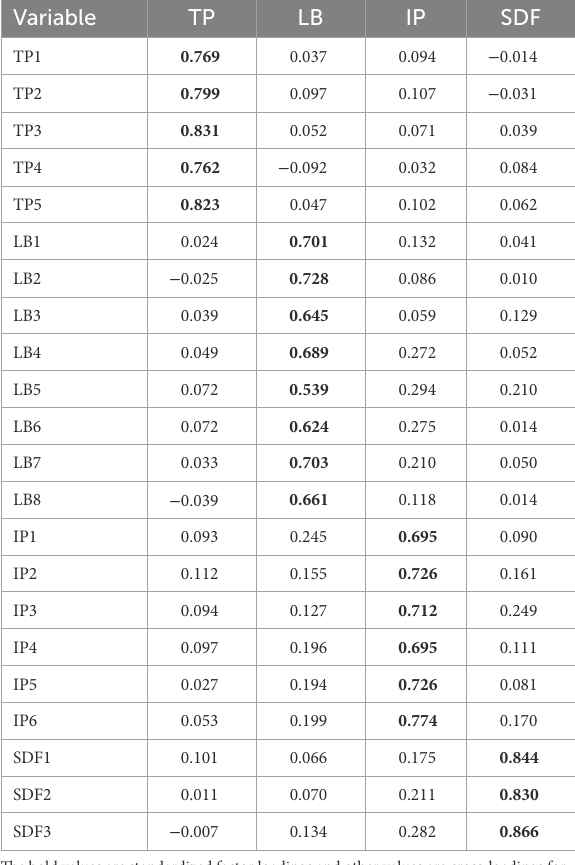
TABLE 4 Results of factor loadings and cross-loadings in Study 2.